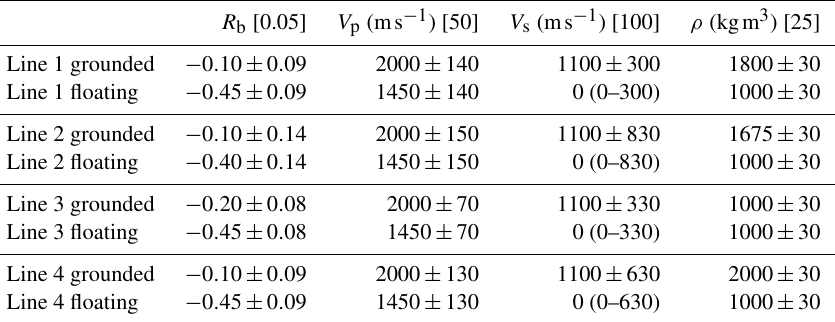
Table 5. Binned-mode seismic properties estimated using normal incidence methods ( R b ) and Zoeppritz fitting ( V p , V s , and ρ ) for the grounded and floating portions of each line. Bin sizes are shown in square brackets. The 1 standard deviation uncertainties were obtained from the misfit in the floating portion of each